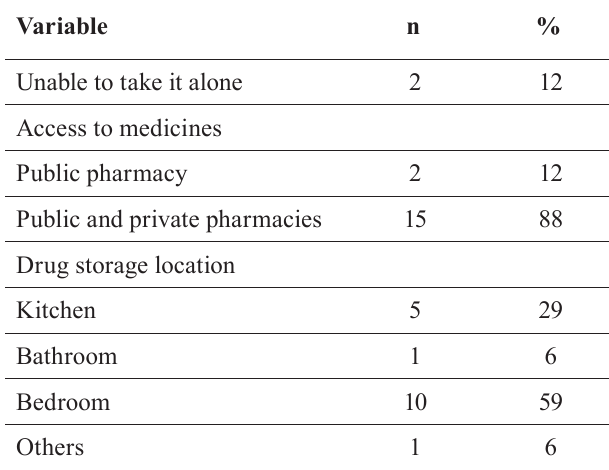
TABLE I - S ociodemographic, behavioral and drug utilization characteristics of T2DM patients included in the Pharmaceutical Care Program for the pharmacotherapeutic management at UP, Juiz de Fora-MG, Brazil (n=17) Variable